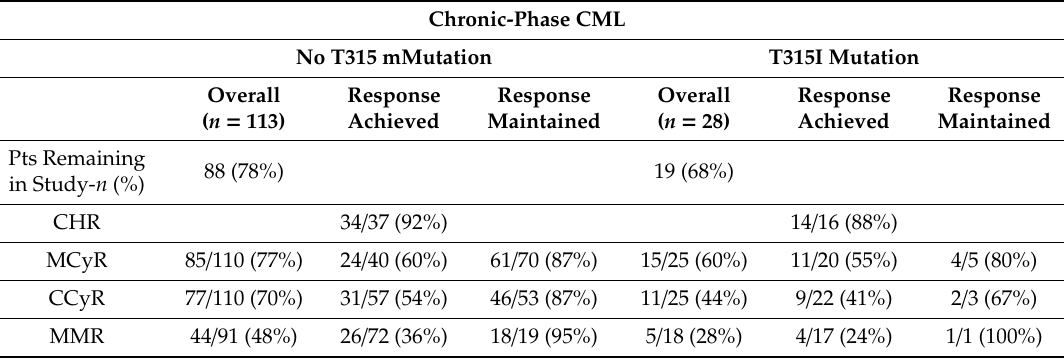
Table 3. Responses in asciminib treated